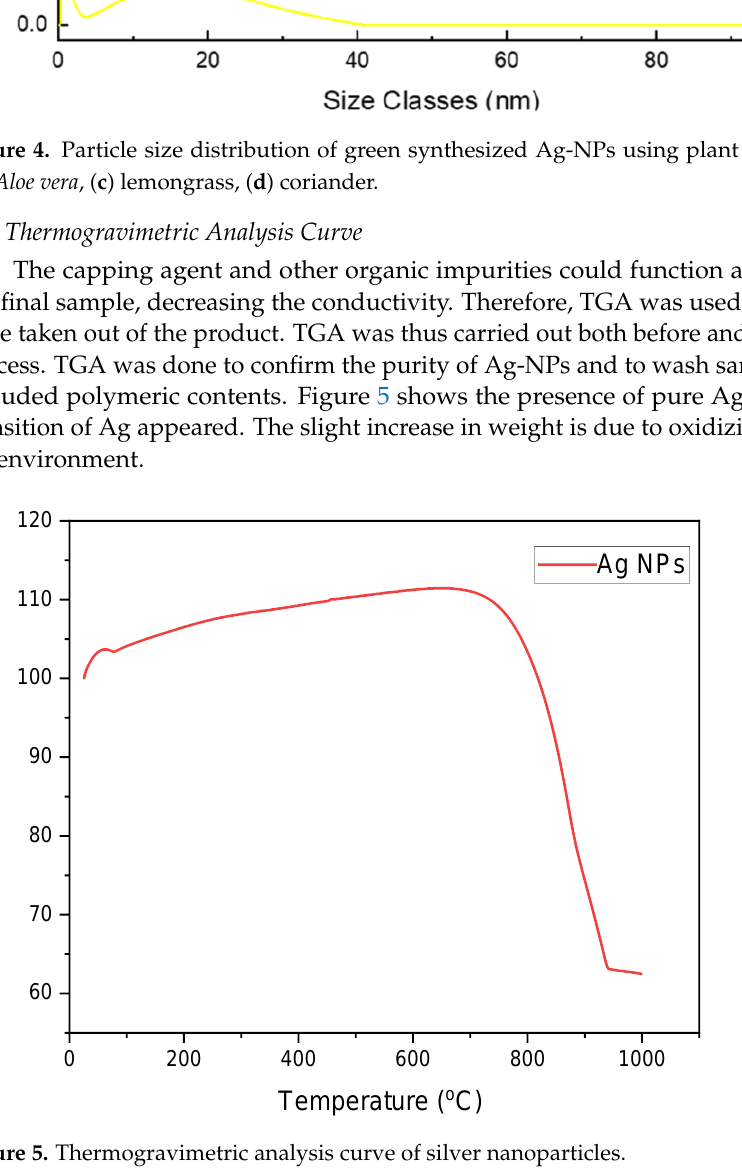
Figure 5. Thermogravimetric analysis curve of silver nanoparticles .